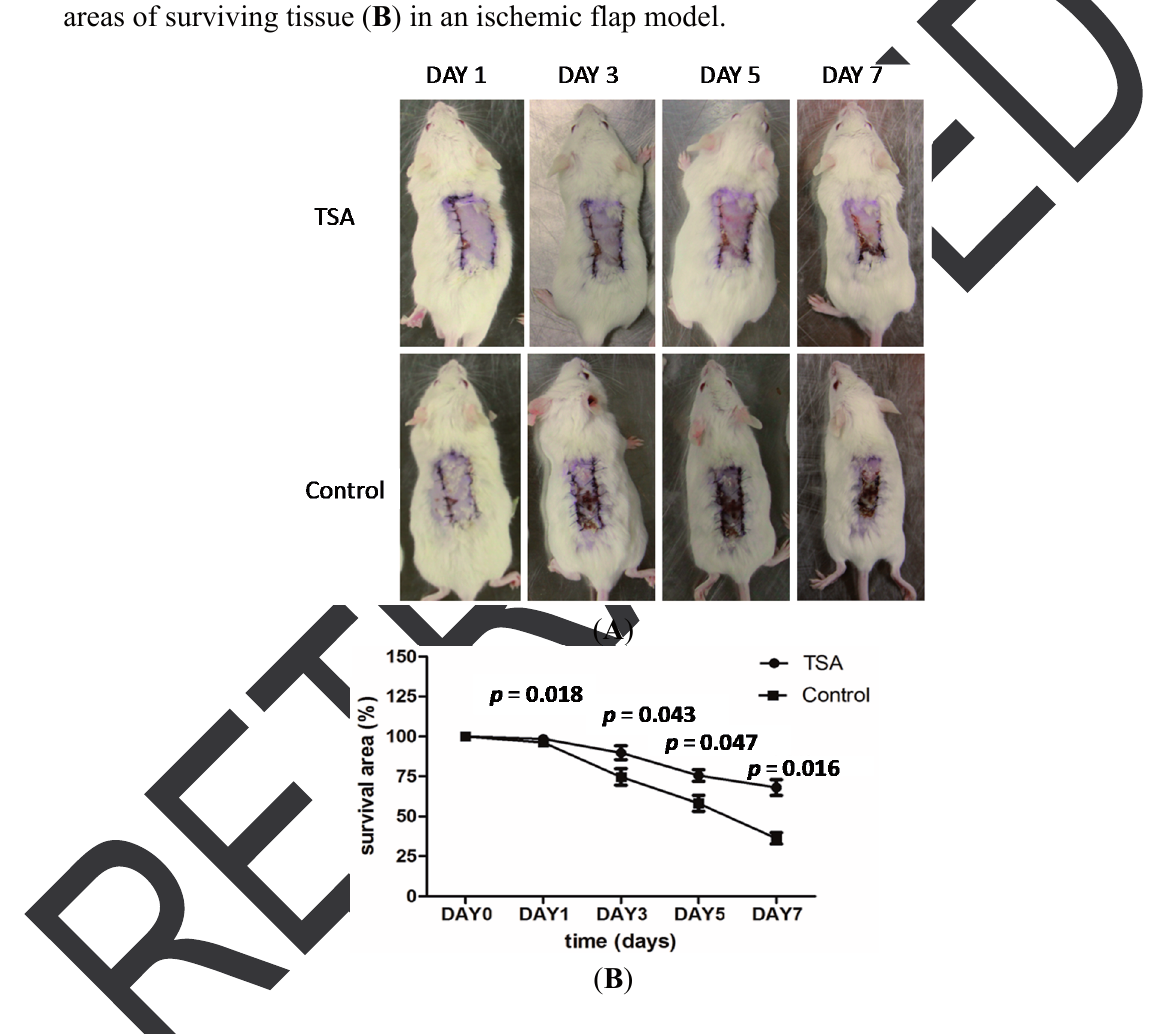
Figure 3. Pretreatment with TSA enhanced resistance to hypoxia ( A ) and resulted in larger areas of surviving tissue ( B ) in an ischemic flap